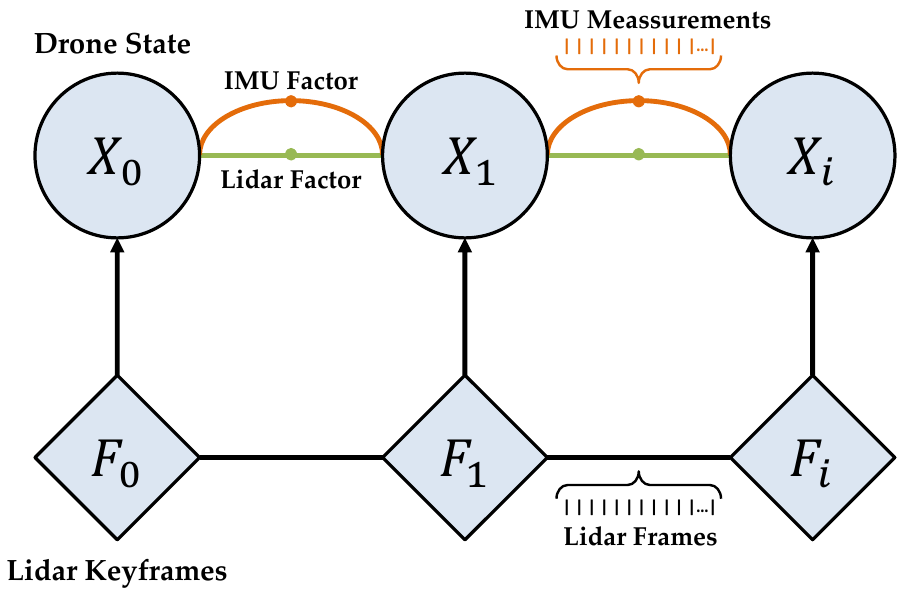
Figure 9. LIO-SAM adapted factor